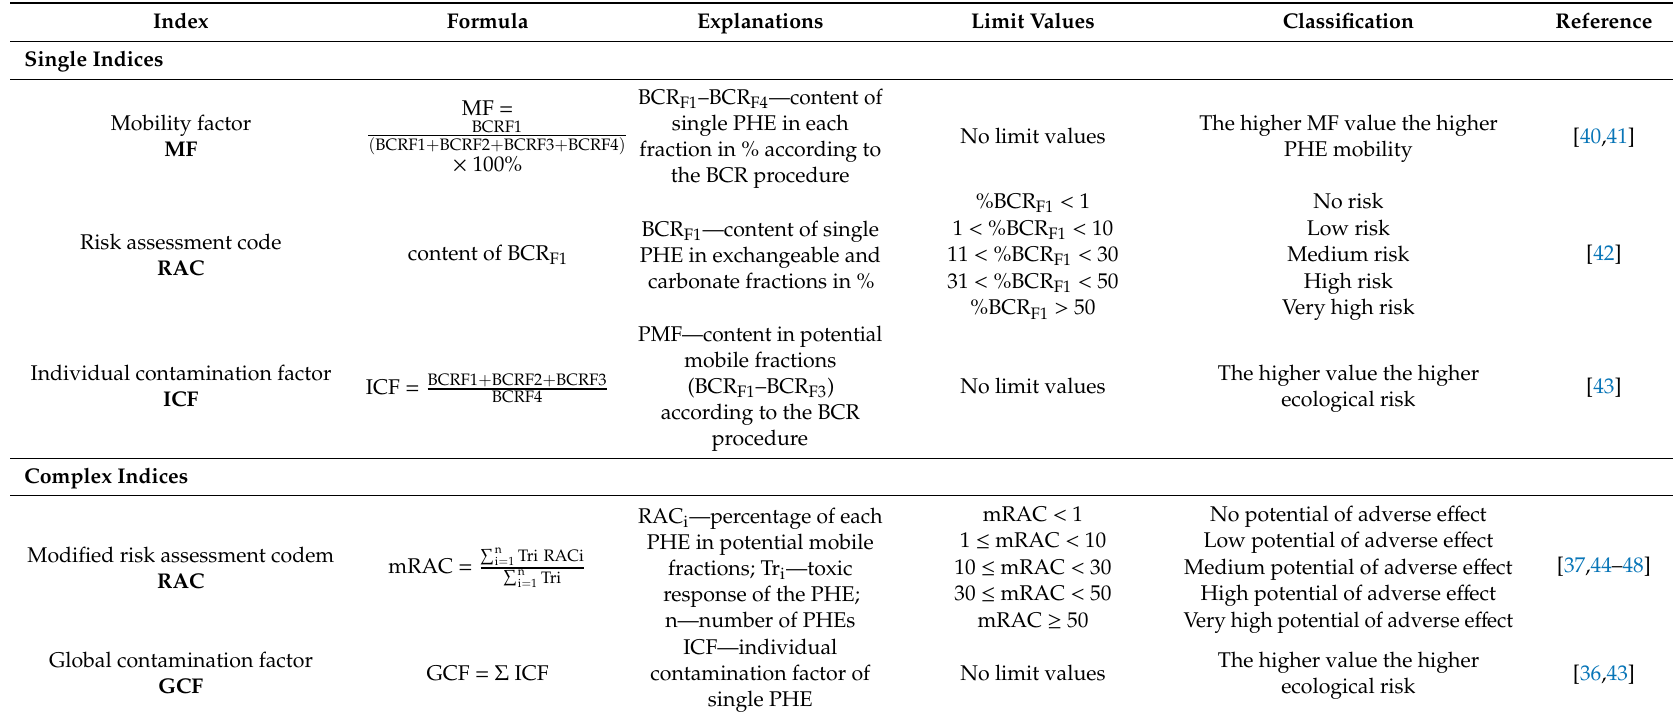
Table 1. Description of the geochemical fractionation indices applied in the